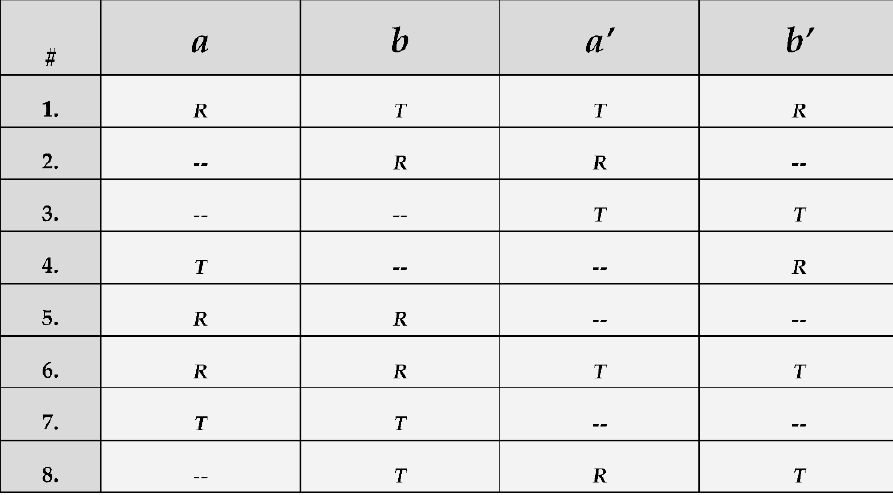
Figure 2. Coincidence pattern in a four-quantum experiment. If a set of four entangled beams is measured in the same way, the rates of coincidence are expected to be constant for any number of events (2, 3 or 4). If each beam is measured for a different variable, as shown, then two-quantum coincidences are expected to outnumber four-quantum coincidences for sharp measurements. In this case, ( a,b ) coincidences can be seen in iterations 1, 5, 6 and 7, while quadruple coincidences can only be found in iterations 1 and 6. This is a known trait of relevant experiments, but the theoretical significance of these patterns (as a necessary feature, rather than a technological limitation) was only recently evaluated, as shown in the text.